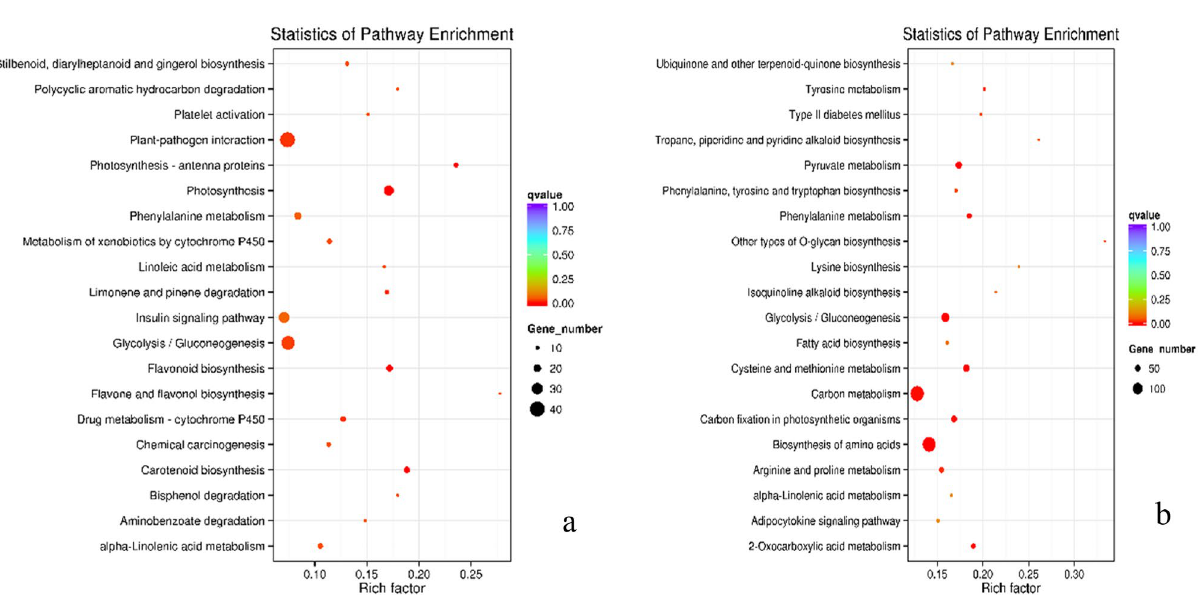
Figure 3. KEGG pathway enrichment analysis of genes differentially expressed between oil palm fruit types and at different fruit development stages. ( a ) Nigrescent immature/mature type. ( b ) Virescent immature/mature